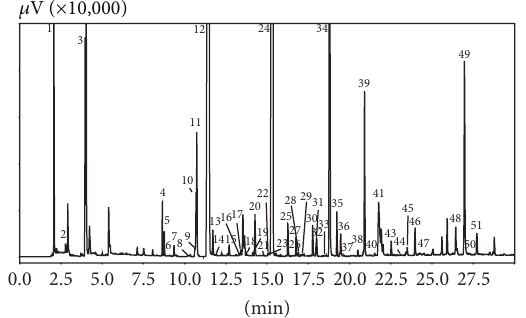
Figure 1: HS-SPME-GC-FID chromatogram of a fresh A. bisporus sample. Peak top numbers refer to Table